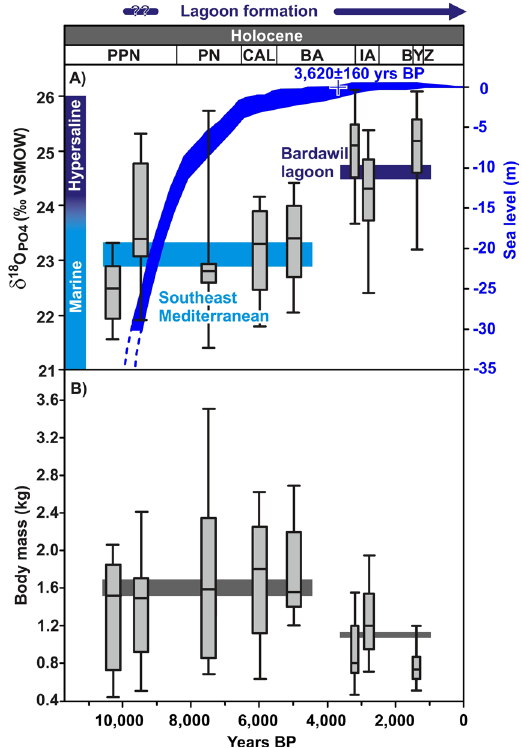
Figure 4. Temporal evolution of phosphate oxygen isotope ( δ 18 O PO4 ) composition in archaeological Sparus aurata tooth enameloid and estimated body mass. ( A ) Box plots of δ 18 O PO4 values of S . aurata from 12 different archaeological sites in the southern Levant (Fig. 2), spanning the time from the Pre-Pottery Neolithic until the Byzantine period (Table S1). Note, different width of the box plots reflects the age ranges of each site (see Table S1 for details). Changes of Eastern Mediterranean Sea level are taken from 44,45 . The sea level stabilised at the present level ( ± 1 m) about 1,600 years BCE 46 , allowing the formation of the shallow, hypersaline Bardawil lagoon on the shallow shelf of the Sinai coast (Fig. 1). For comparison on the left y-axis the ranges of δ 18 O PO4 values expected for S . aurata that formed their teeth in the Bardawil lagoon and in the southeast Mediterranean (Fig. 3) are given. ( B ) Box plots of estimated body mass of S . aurata . Tooth δ 18 O PO4 of S . aurata increased to hypersaline values and at the same time fish body mass decreased significantly. Coloured horizontal boxes represent mean values and standard error of δ 18 O PO4 and body mass of S . aurata from the PPN-EBA and LBA- BYZ time